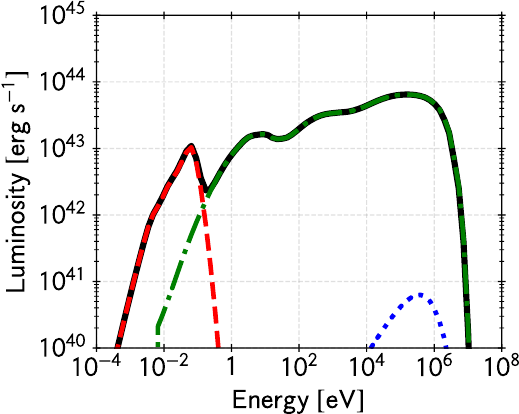
Figure 1. Spectral energy distribution for the emission of thermal electrons in the hot accretion flow for our fiducial model (see Table 1). The different emission processes are shown. Synchrotron: red dashed , Bremsstrahlung: blue dotted , and Inverse Compton: green dot-dashed (several peaks). The black solid curve is the total